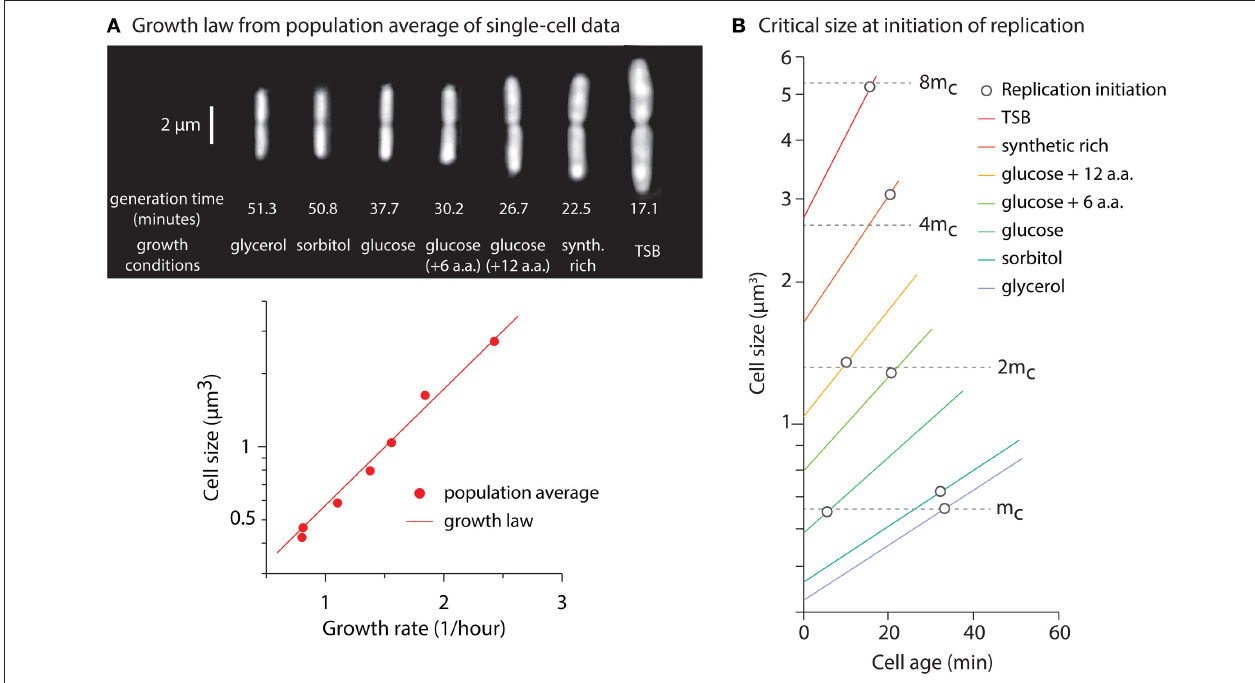
FIGURE A3 | (A) (Top panel) Typical dividing cells of an isogenic E. coli strain under various growth conditions. (Bottom panel) To extract C + D, we fit m ( T ) = m 0 2 ( C + D ) / T to population average data. Here, growth rate is defined as ln (2) / T . (B) Self-consistency check of Donachie’s critical size in our data. Each line shows average cell-size from birth to division as a function of cell age. The circle markers refer to initiation of replication, calculated by retracing average cell size C + D minutes before each division. Panel (A) is reproduced from Taheri-Araghi et al. (2015a) with permission from Elsevier.